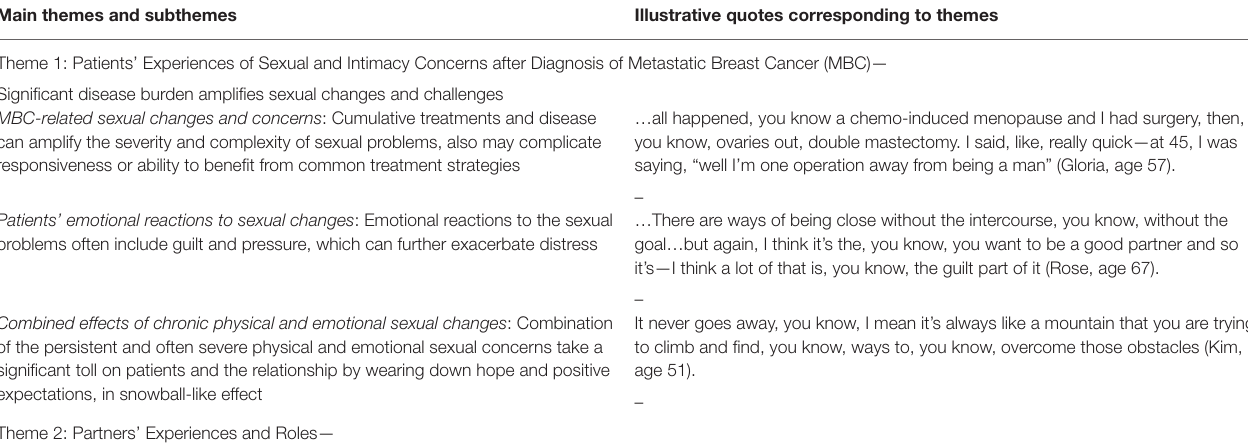
TABLE 3 | Part 1: Qualitative themes 1–3 and illustrative quotes: patients’ and partners’ experiences of sex and intimacy after MBC